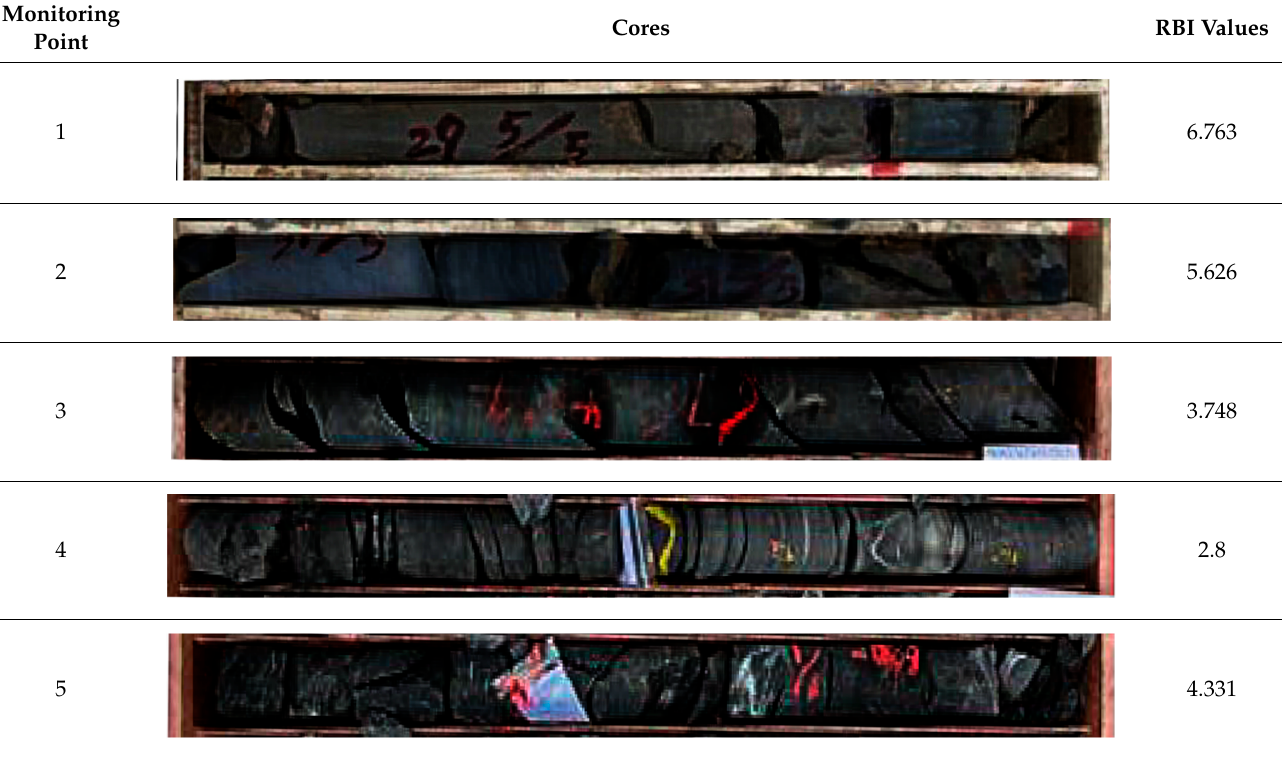
RBI RBI RBI Values